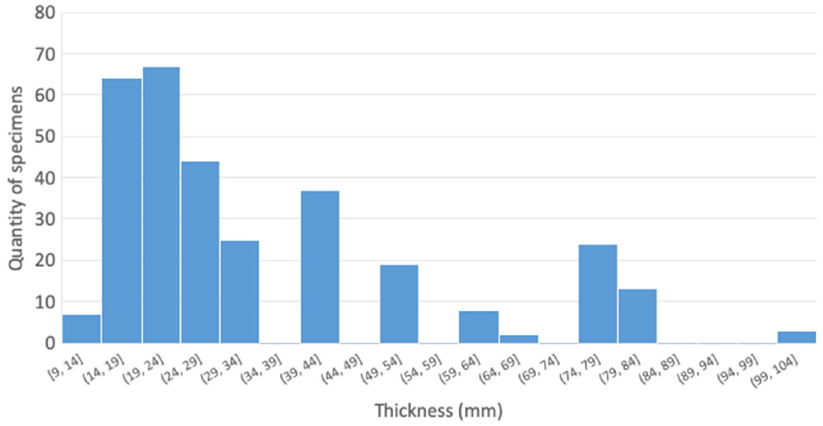
Figure 11. Histogram of thickness with in-air transverse butt-welded joint Figure 13. Histogram of thickness with in-air transverse butt-welded joint samples .